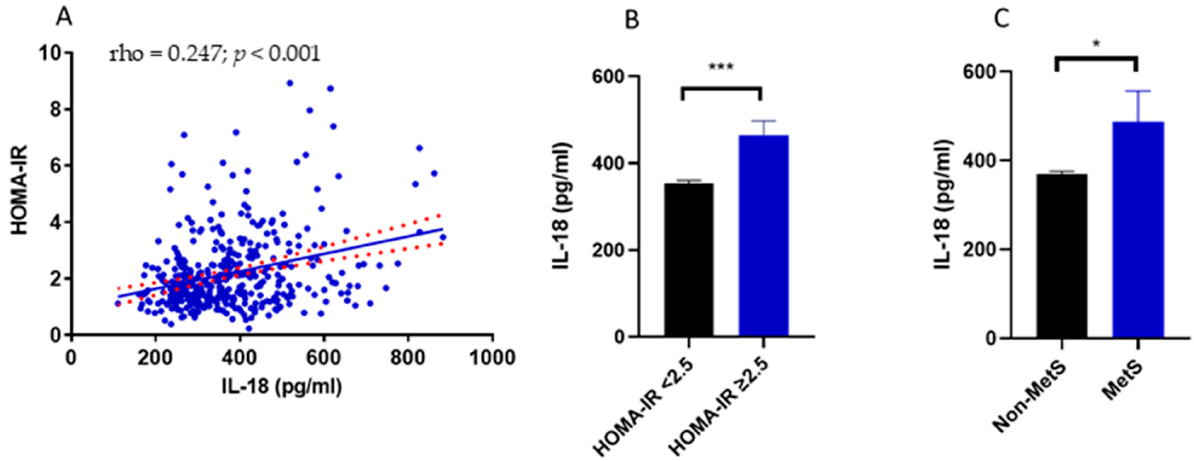
Figure 1. ( A ) Spearman correlation analysis between HOMA-IR and IL-18 circulating levels. Data analysis performed using Spearman correlation analysis is reported in Table 2. ( B ) IL-18 circulating levels in individuals with a HOMA-IR either <2.5 or ≥ 2.5. ( C ) IL-18 circulating levels in individuals affected by the metabolic syndrome or not meeting the diagnostic criteria for the metabolic syndrome. Data in B and C are reported as mean ± SEM. Differences between groups in B and C were assessed using t -test of log-transformed IL-18. * p value < 0.05, *** p value < 0.001. rho, Spearman’s rho correla- tion coefficient; HOMA-IR, homeostatic model assessment for insulin resistance; IL-18, interleukin 18; MetS, metabolic syndrome. Table 2. Spearman correlation between Il-18 and HOMA-IR with parameters of interest.